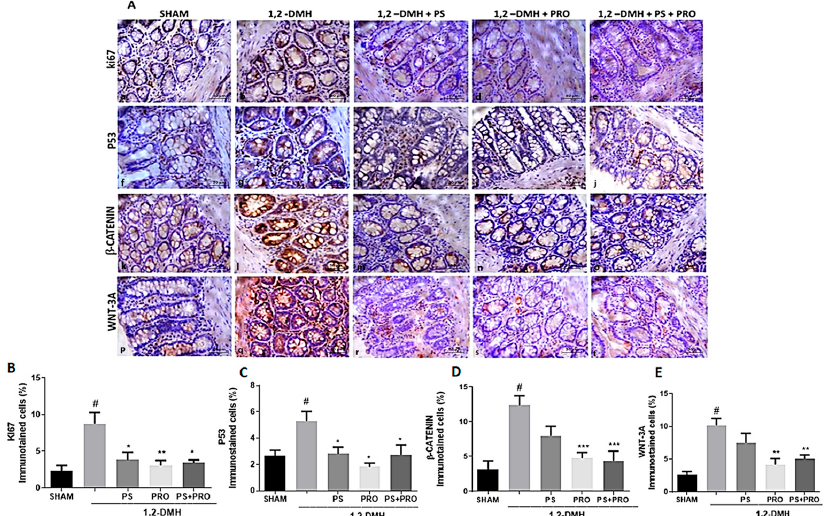
Figure 5. Immunoexpression of Ki67, P53, β -catenin, and Wnt-3a proteins in the distal colon. ( A ) Representative histology of Ki67, P53, β -catenin, and Wnt-3a protein immunolabeling in the experimental groups. The graphs ( B – E ) represent the mean ± SEM of the percentage of the immunoposi- tive area for Ki67, P53, β -catenin, and Wnt-3a in relation to the total area. # p < 0.05 vs. Sham and * p < 0.05, ** p < 0.01, *** p < 0.001 vs. 1,2-DMH group. ( B , C ) The data were analyzed using the Kruskal– Wallis test followed by the Dunn’s post-test. ( D , E ) The data were analyzed by the one-way ANOVA test followed by the Tukey’s post-test.